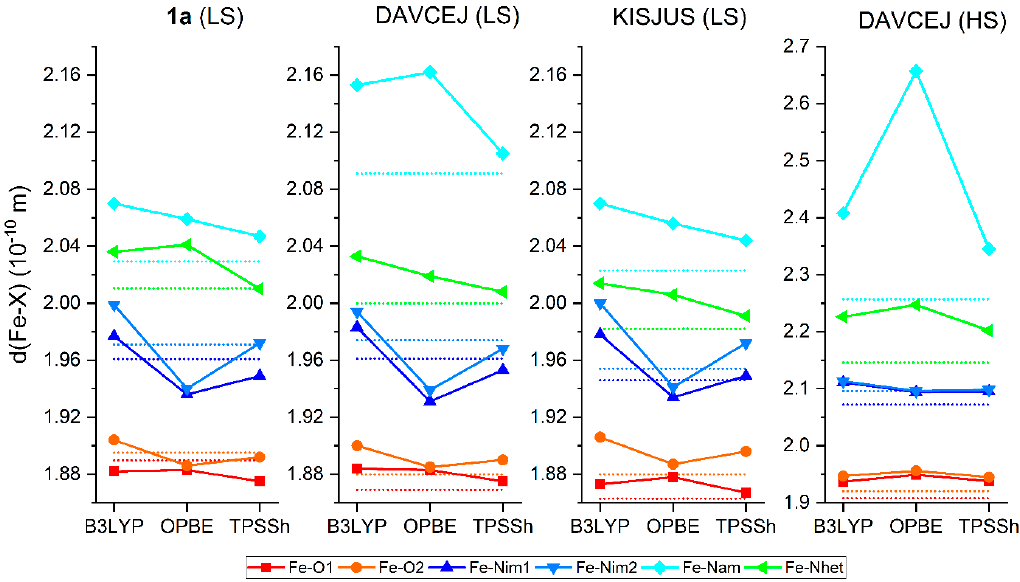
Figure 3. The variation of the donor–acceptor distances in DFT-optimized geometries (full lines + symbols) compared to the experimental X-ray data (dotted lines).